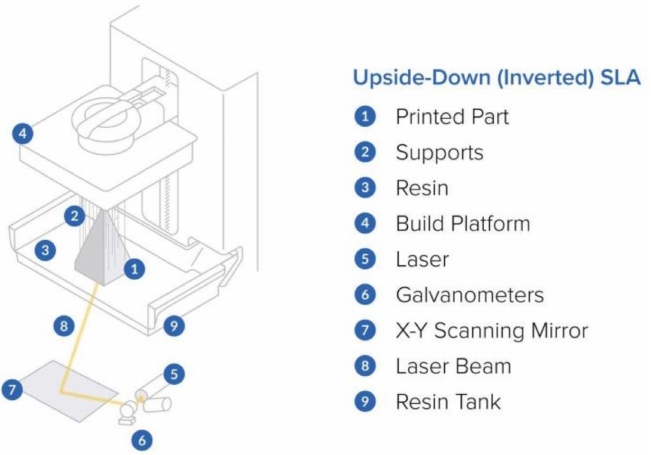
Figure 3. Graphical representation of the basic components in a stereolithography (SLA) 3D printer